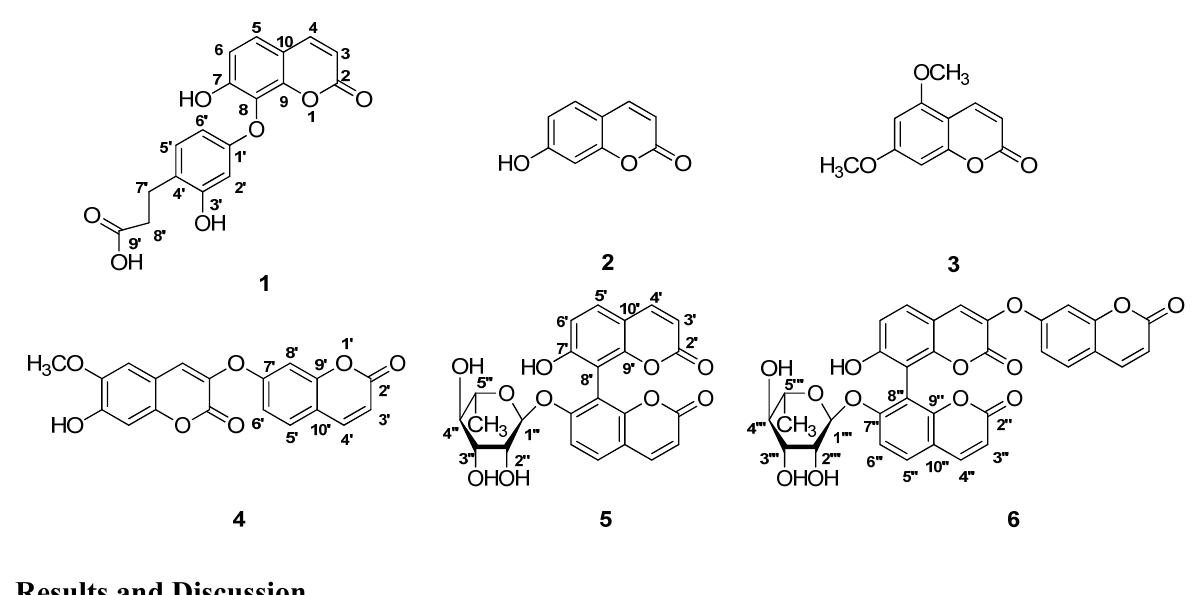
Figure 1. Chemical structures of compounds 1 – 6